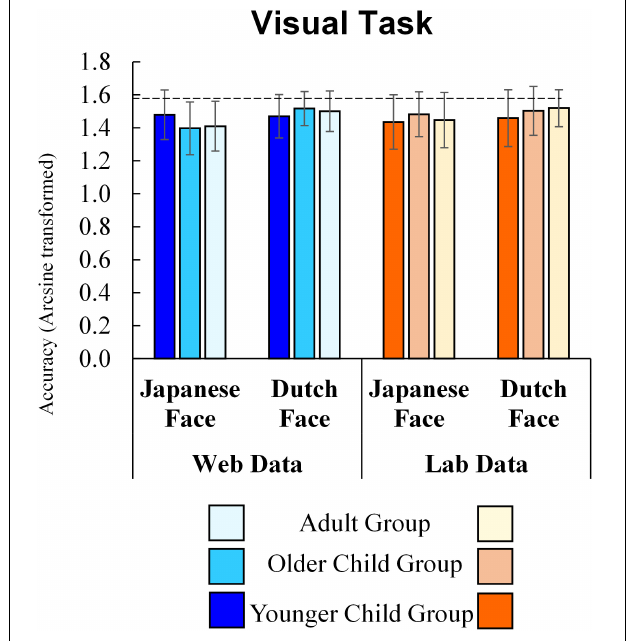
FIGURE 4 | Visual task Accuracy (Error bars indicate standard deviations and a dashed line indicates a perfect score).